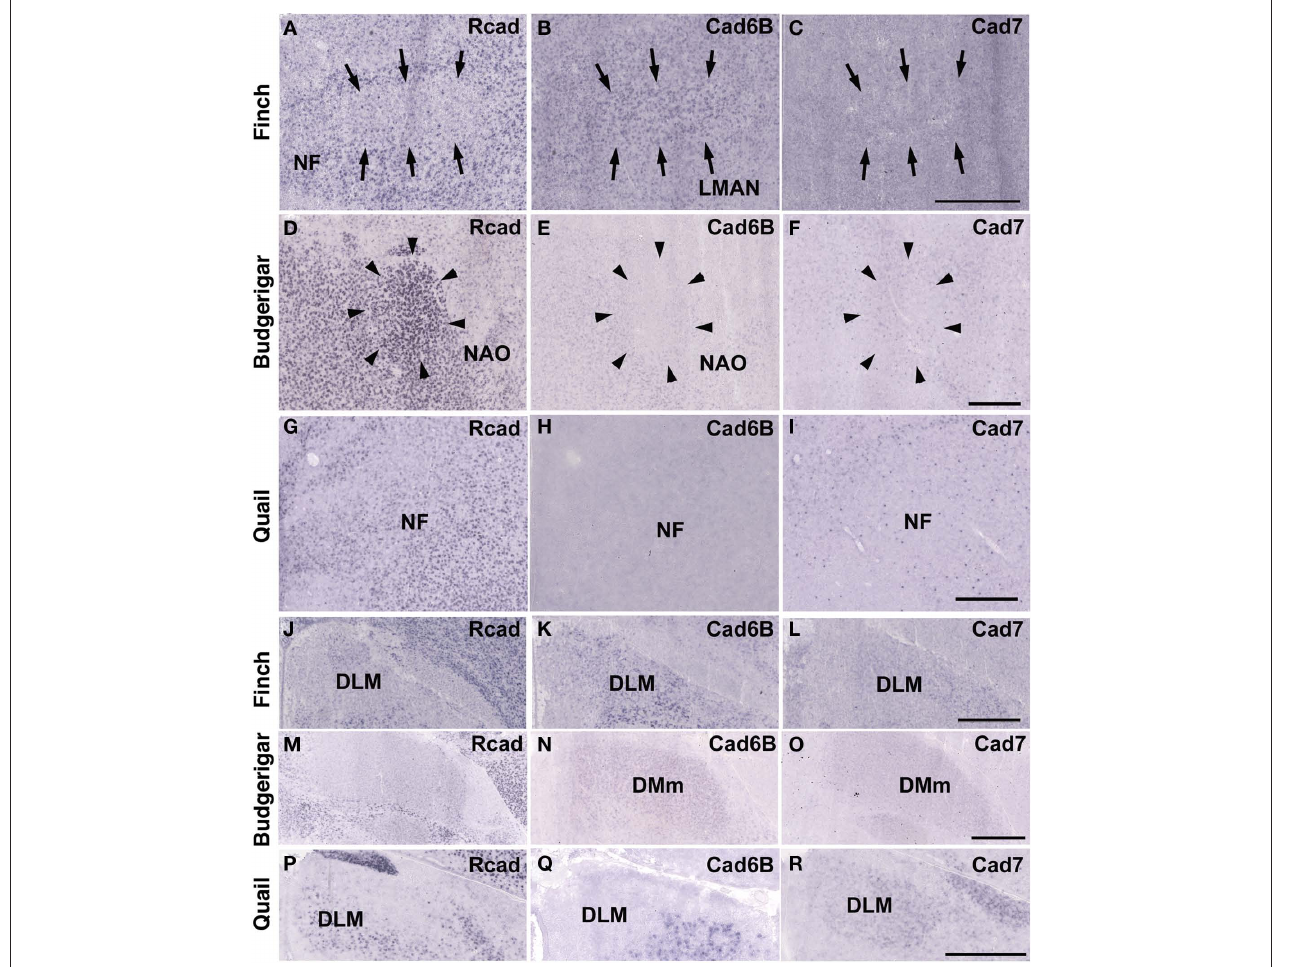
the LMAN of Bengalese finch, Rcad was expressed, but Cad6B was not expressed in the NAO (D,e) . (g–i) Cadherin expression in the frontal nidopallium of quail at the level corresponding to the LMAN and the NAO. (J–L) Cadherin expression in the DLM of Bengalese finch. (M–O) Cadherin expression in the DMm of budgerigar. (P–r) Cadherin expression in the dorsolateral region of the thalamus of quail. Scale bars are